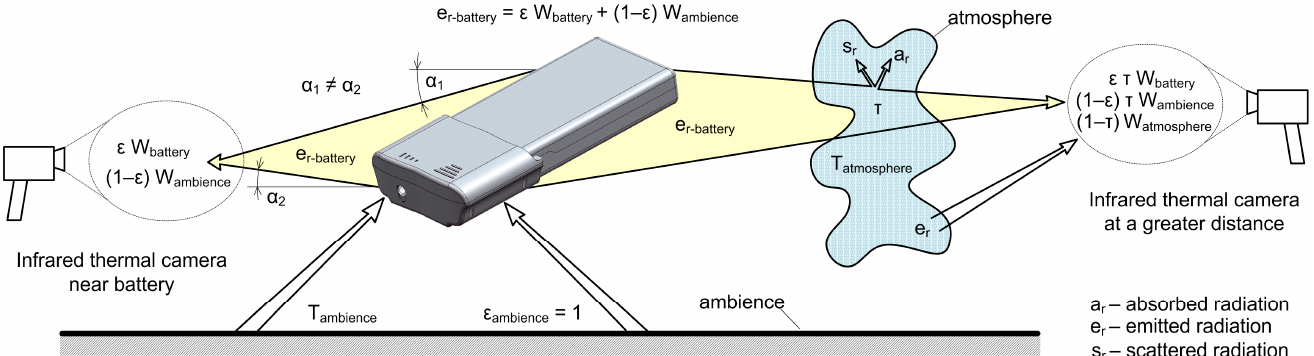
Figure 4. Components of longwave infrared radiation registered by the infrared thermal camera.